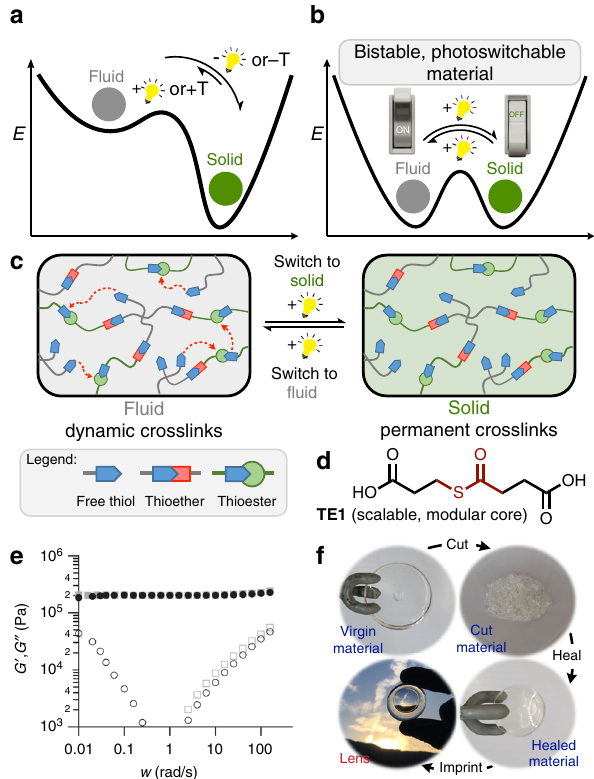
Fig. 1 Concept of a bistable, photoswitchable state of matter. a The application of a given stimulus (i.e., heat or light) to a solid material overcomes the unfavorable solid to fl uid phase transition in covalent adaptable networks; removal of the stimulus returns the material to the favored solid phase. b Equivalent energetic favorability of the fl uid and solid phase of a covalent adaptable network with a small barrier allows for permanent, bistable switching of phase with light. c A cartoon of how light can effectively switch the state of matter in a network polymer. d Rheometry shows that thioester crosslinked materials act as fl uids when thiol, thioester, and a base catalyst (PMDETA) are present (G ′ = black fi lled circle; G ″ = black open circle), and as solids when the base catalyst is removed (G ′ = grey fi lled square; G ″ = grey open square). e The ability of thioester crosslinked materials while in the fl uid phase to undergo large changes in structure at room temperature is indicated by the ability to shred and subsequently heal the material into a defect free, optically active